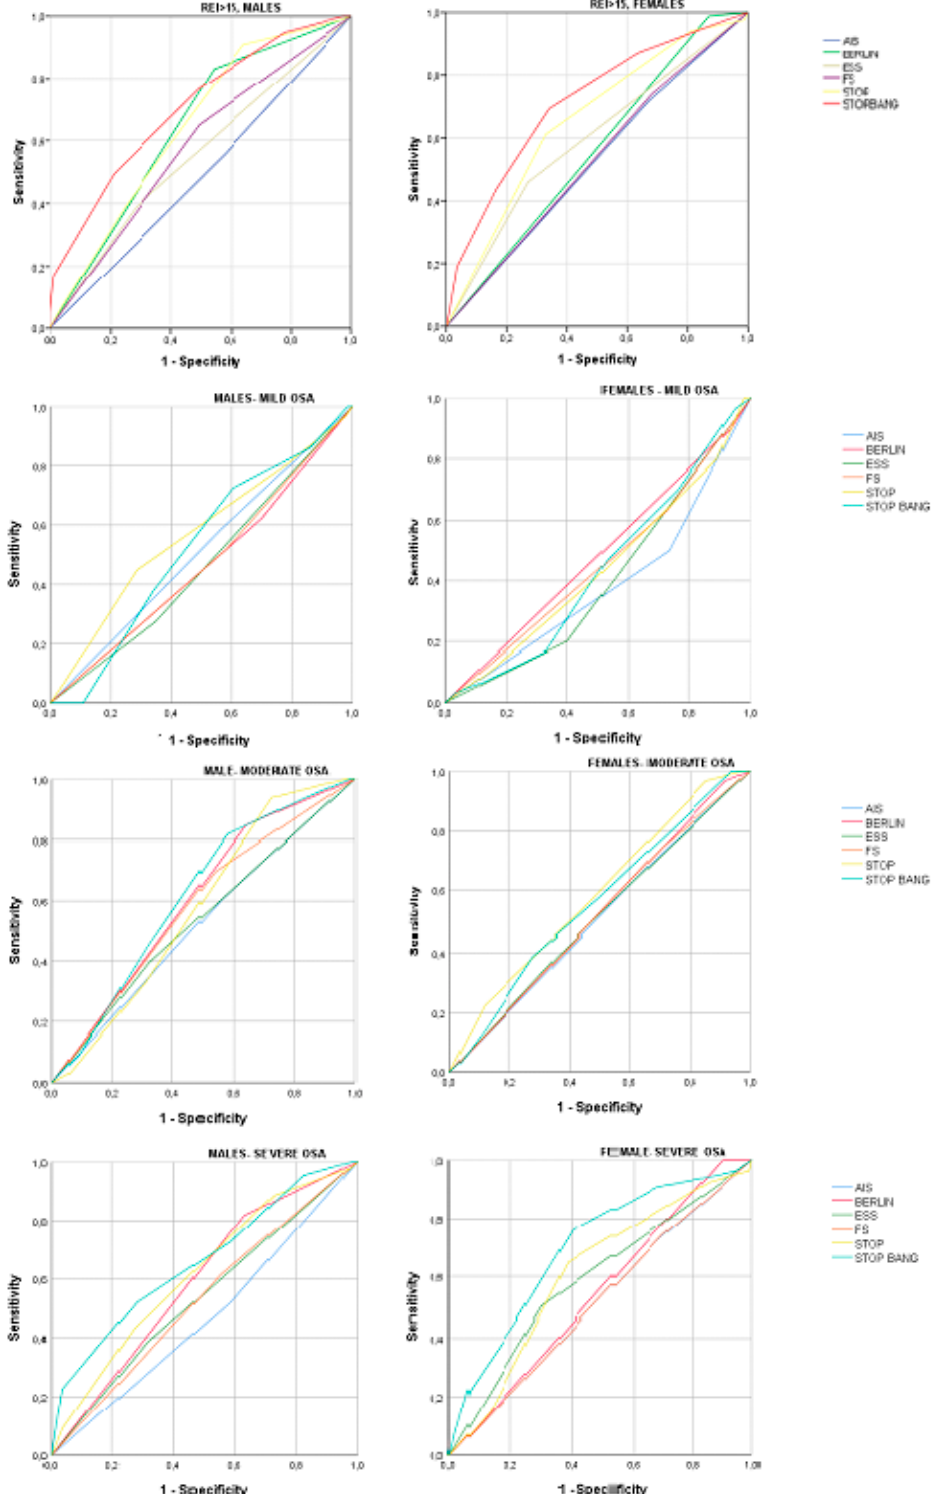
Figure 1. Area under the curve (AUC) of receiver operating characteristic (ROC) curves for the discriminatory ability of each questionnaire in both genders in the different severity groups of OSA (for REI > 15, mild, moderate, and severe OSA). ESS = Epworth Sleepiness Scale, BERLIN = Berlin Questionnaire, AIS = Athens Insomnia Scale, and FS = Fatigue Scale.